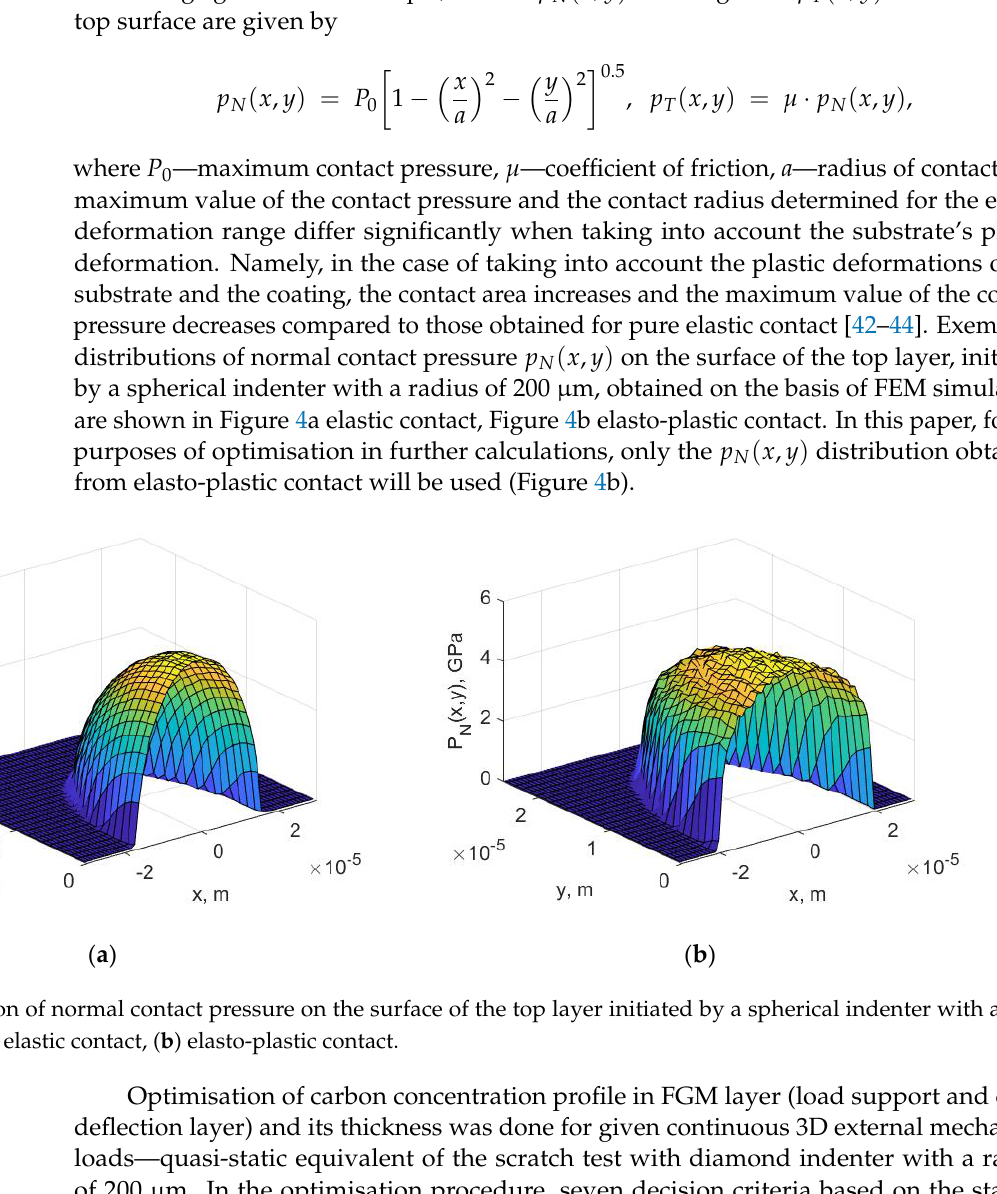
Figure 3. Scheme of the optimisation procedure.